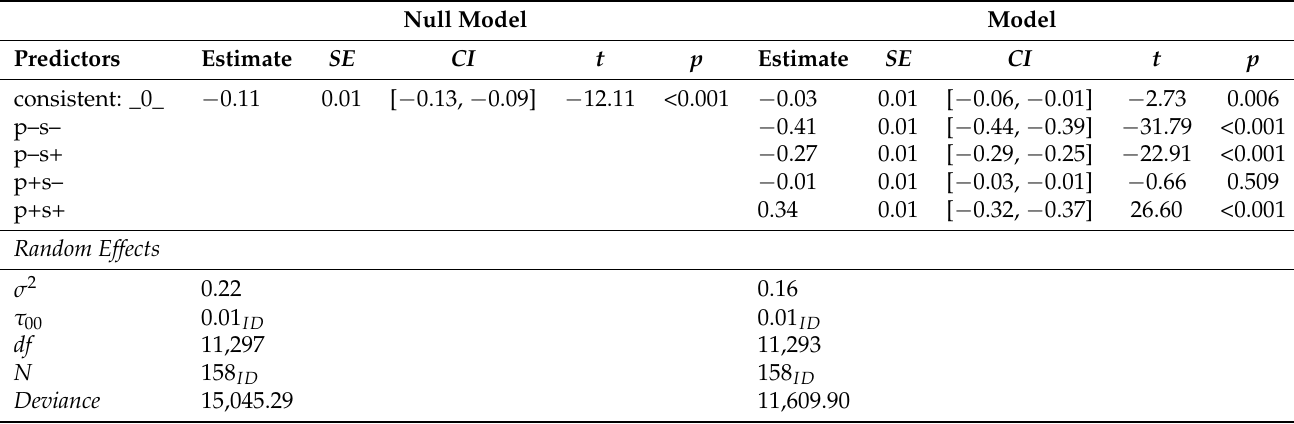
Table A8. Mixed model of the influence of specific stimuli conditions on the emospace valence vector response.